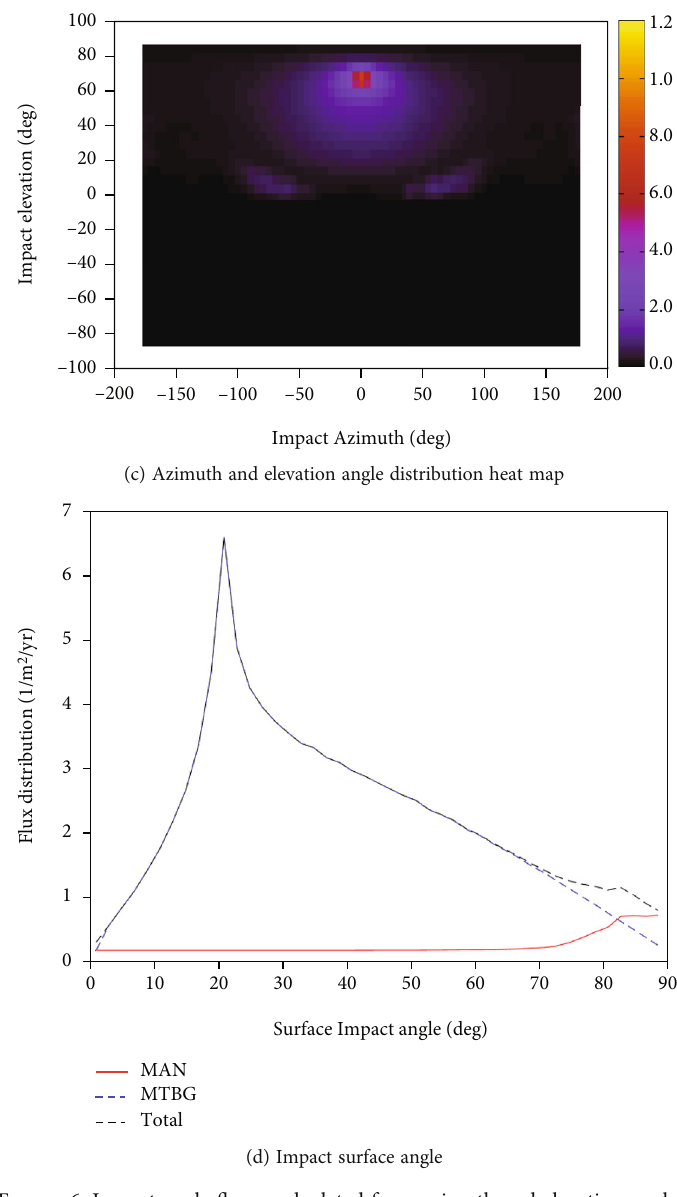
Figure 6: Impact angle fl uxes calculated from azimuth and elevation